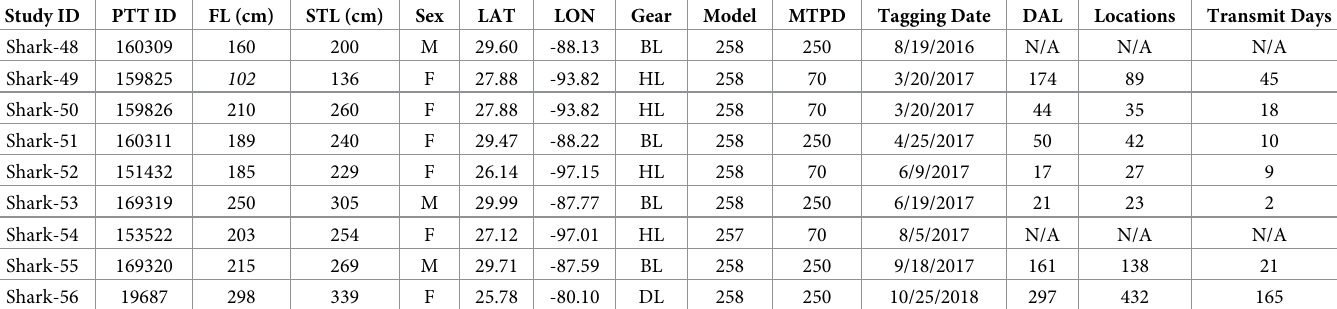
considered mature at 265 and 258 cm FL for females and males, respectively. A conventional mark-recapture tag was attached on the trunk of each individual at the base of the first dorsal fin and a Smart Position and Temperature (SPOT) transmitting tag (Wildlife Computers, Inc.) secured behind the anterior margin of the first dorsal fin. Data processing and analyses Animal position estimates were downloaded from Argos satellites (CLS America, Inc.). For analyses, we included all position estimates of class B or higher (A, 0, 1, 2, and 3) and excluded